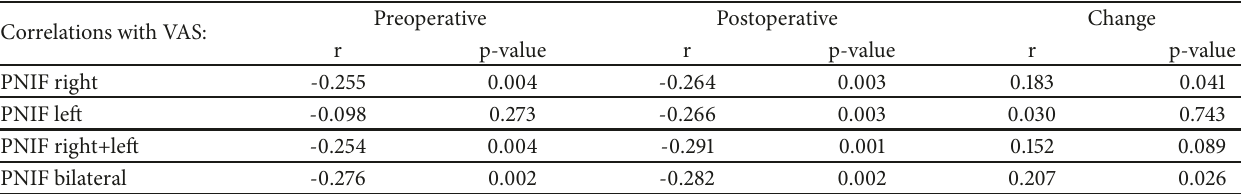
Table 3: Correlations between VAS and PNIF scores pre- and postoperatively and the change from pre- to postoperative measurements. Correlations with